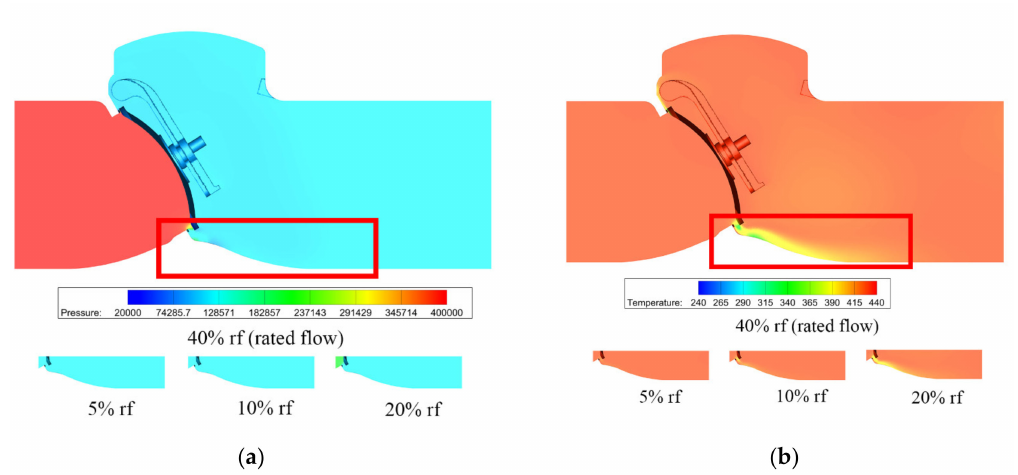
Figure 5. Pressure and temperature distributions under di ff erent mass flow rates: ( a ) pressure distribution; ( b ) temperature distribution.